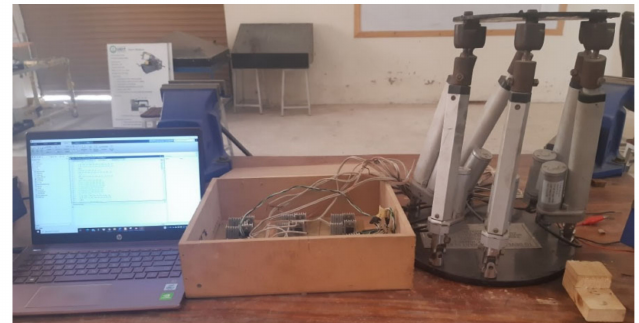
Figure 14. Fabricated model of the six DOF machining